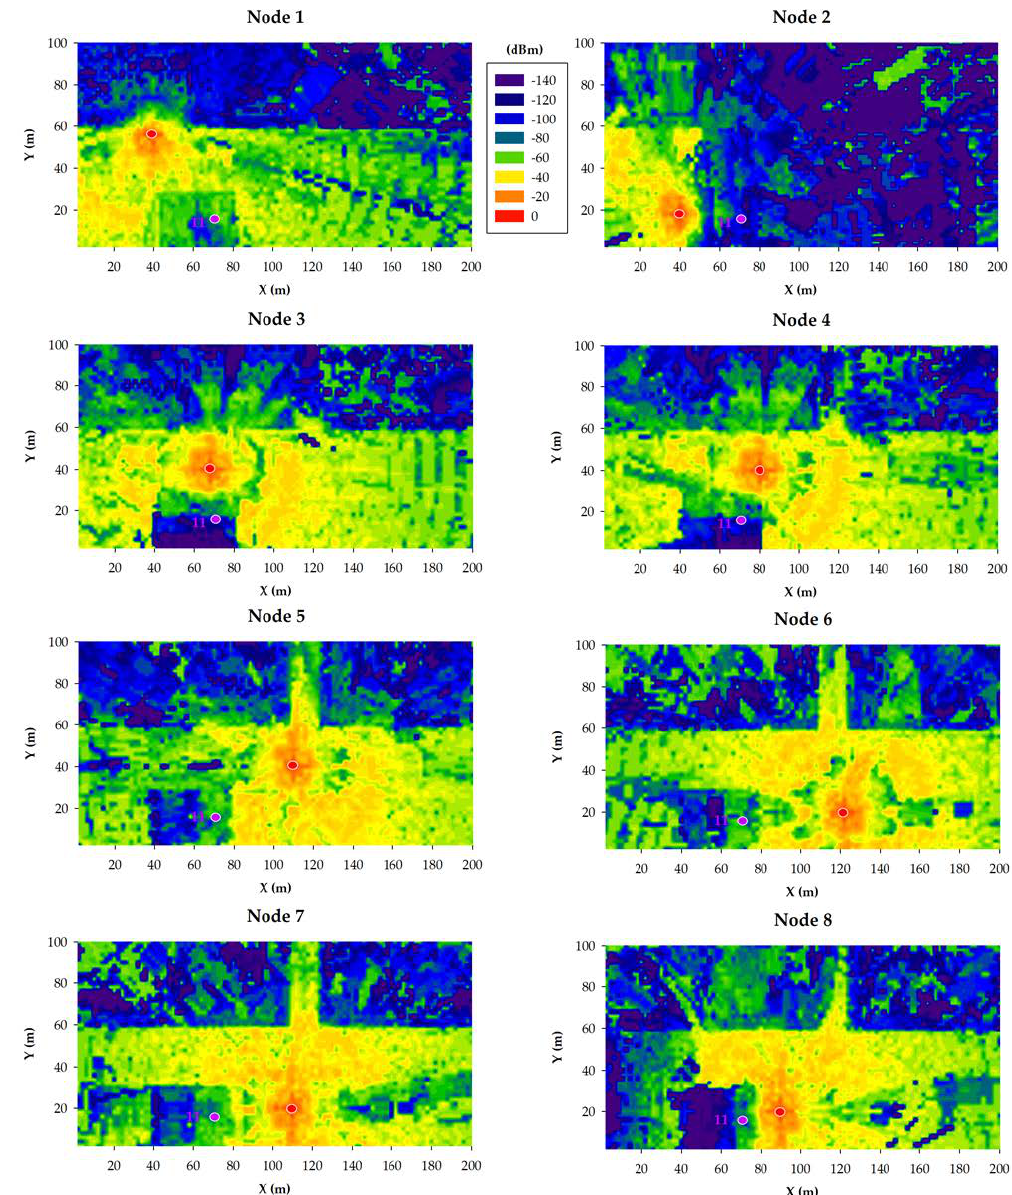
Figure 13. 3D-RL simulation results at 868 MHz: RF power level distribution in a bi-dimensional plane at the height of 5.5